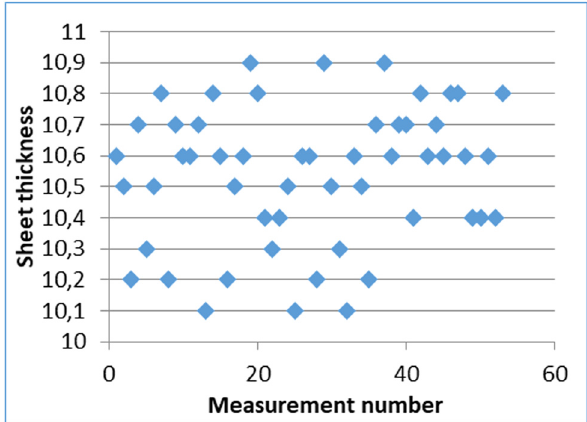
Figure 4: A list of thickness measurements for the fi rst coating sheet of tank one ( taken in 2006 ) .